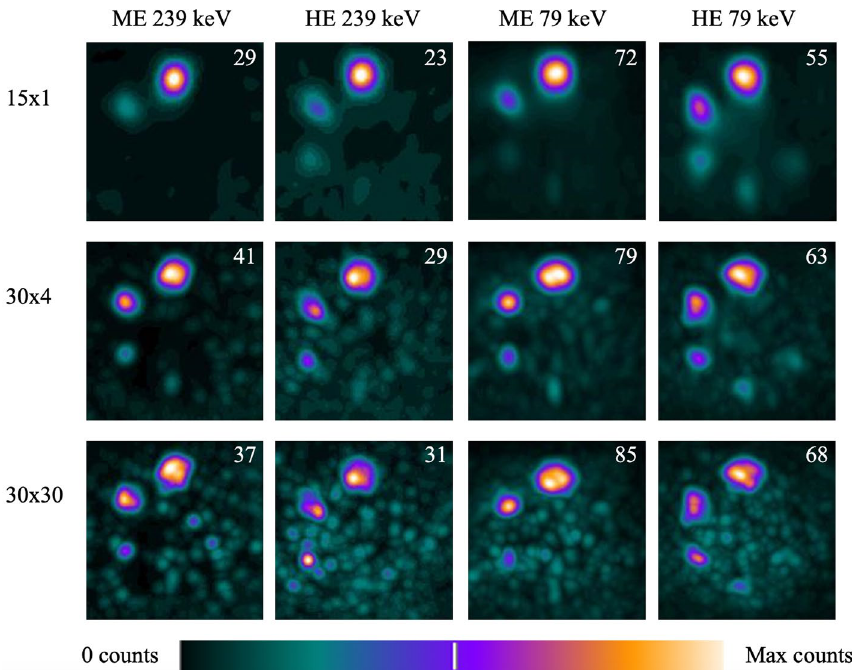
Fig. 8 Selected filtered reconstructed images of the NEMA phantom filled with 17–19 kBq/ml 212 Pb shown as maximum intensity projections. The scale bar is the same for all images, but the maximum counts illustrated in white differs and is given in the top right corner of each